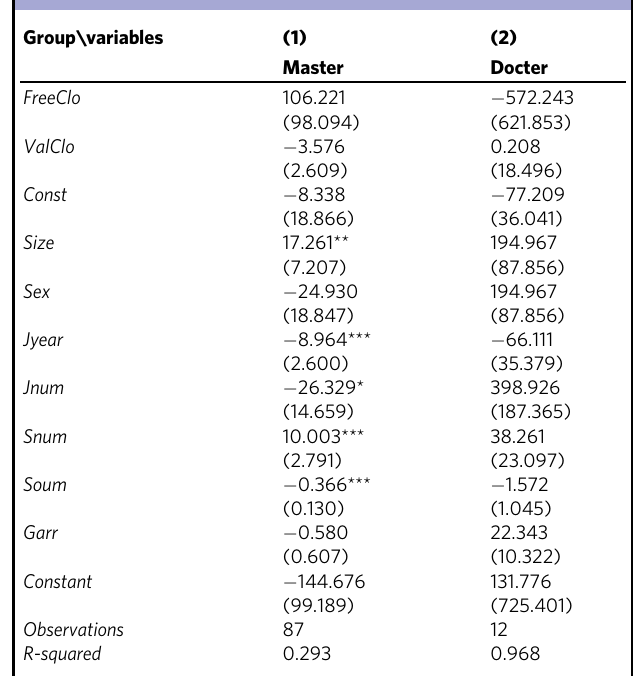
Table 7 Regression results from a diploma heterogeneity